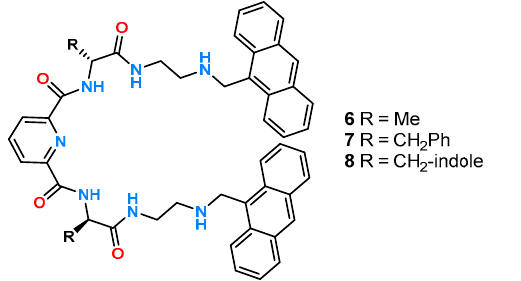
Figure 4. Receptors 6 – 8 based on 2,6-pyridinediamide motif decorated with α -amino acids and anthracene moieties.